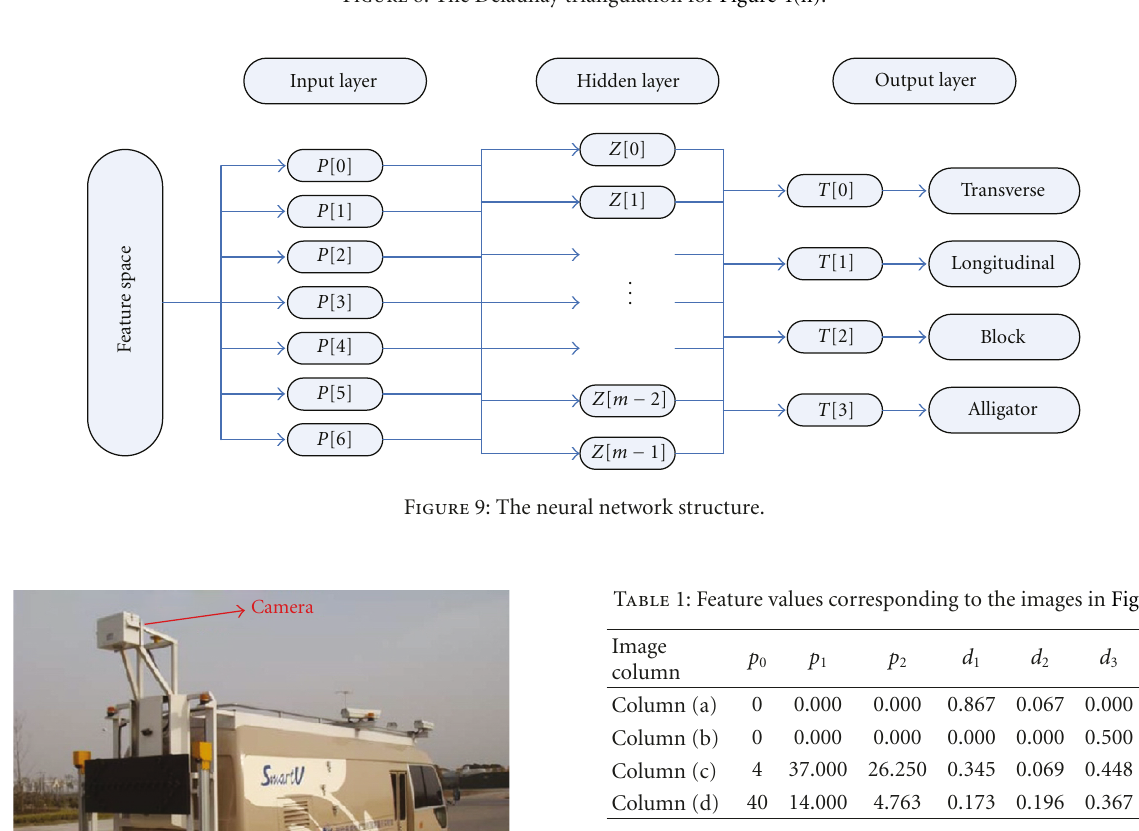
Figure 8: The Delaunay triangulation for Figure 4(h).